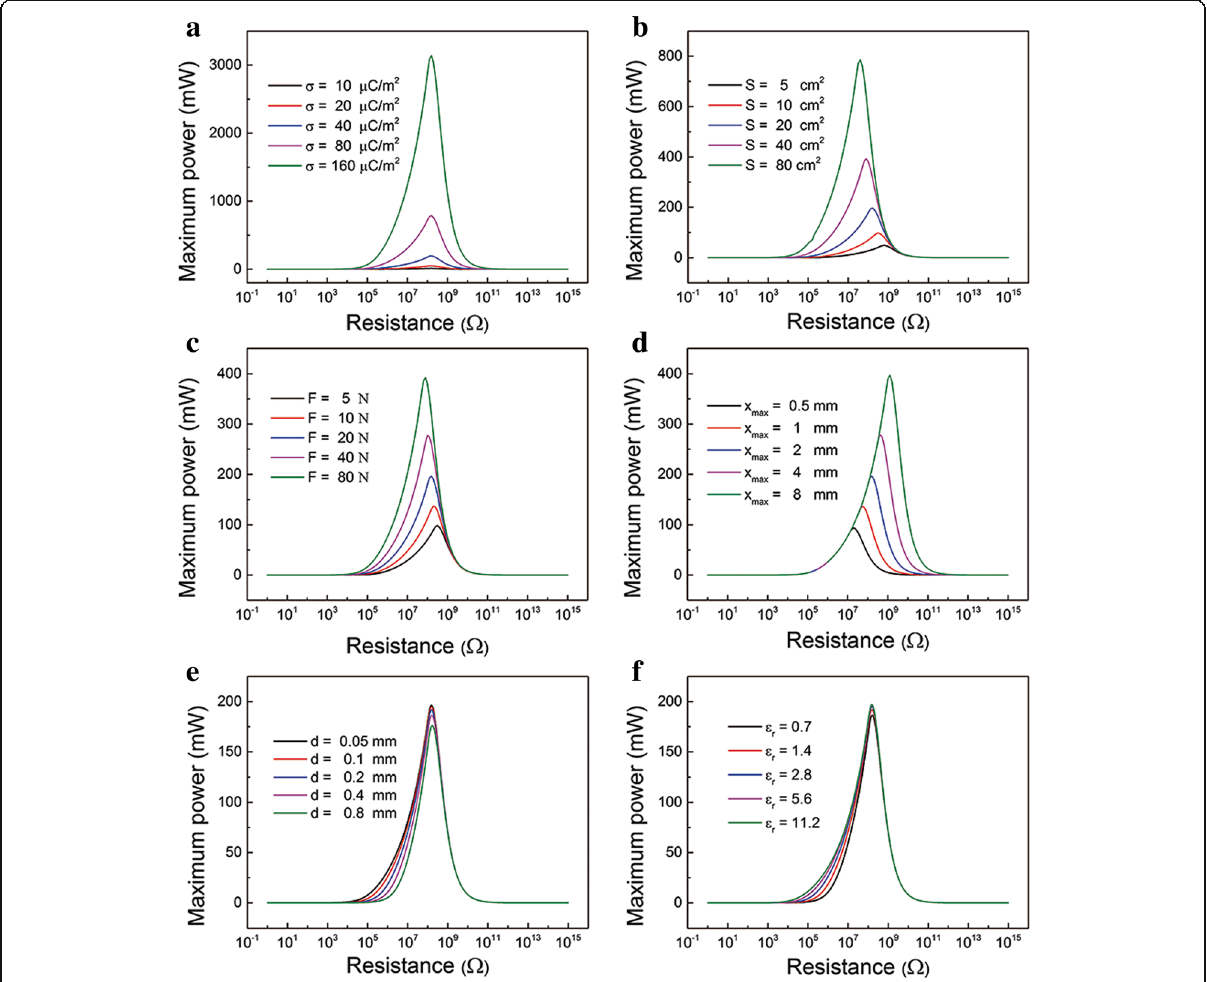
Fig. 3 The effect of parameters on P max and corresponding resistance. Instantaneous power profile with R at different a surface charge density σ , b area size S , c compressive force F , d maximum separation distance x max , e thickness of the dielectric layer d , and f ε